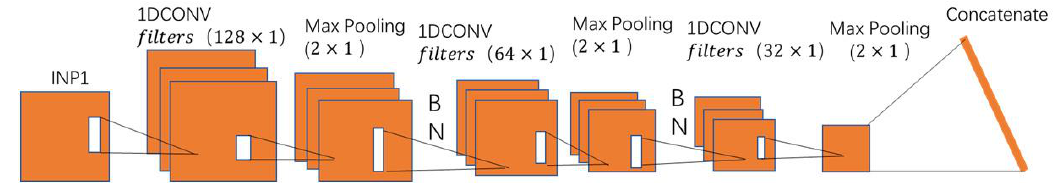
Figure 6. The detailed architecture of the 1-FCLCNN path.